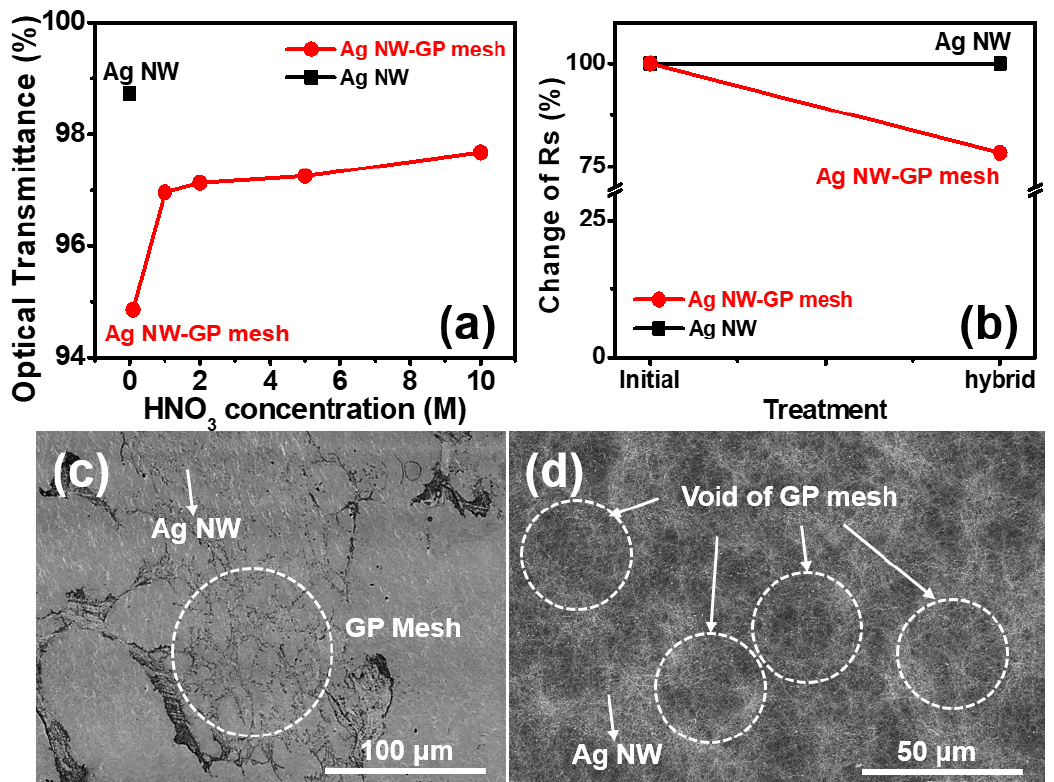
Figure 5. Optical and morphological characterization of Ag NW-GP mesh hybrid. ( a ) optical transmittance and ( b ) electrical conductivity of Ag NW-GP mesh hybrid; morphologies of Ag NW-GP mesh hybrid ( c ) global image of GP mesh in the hybrid by photo-microscopy, ( d ) magnified electronic image of hybrid conductor by SEM.